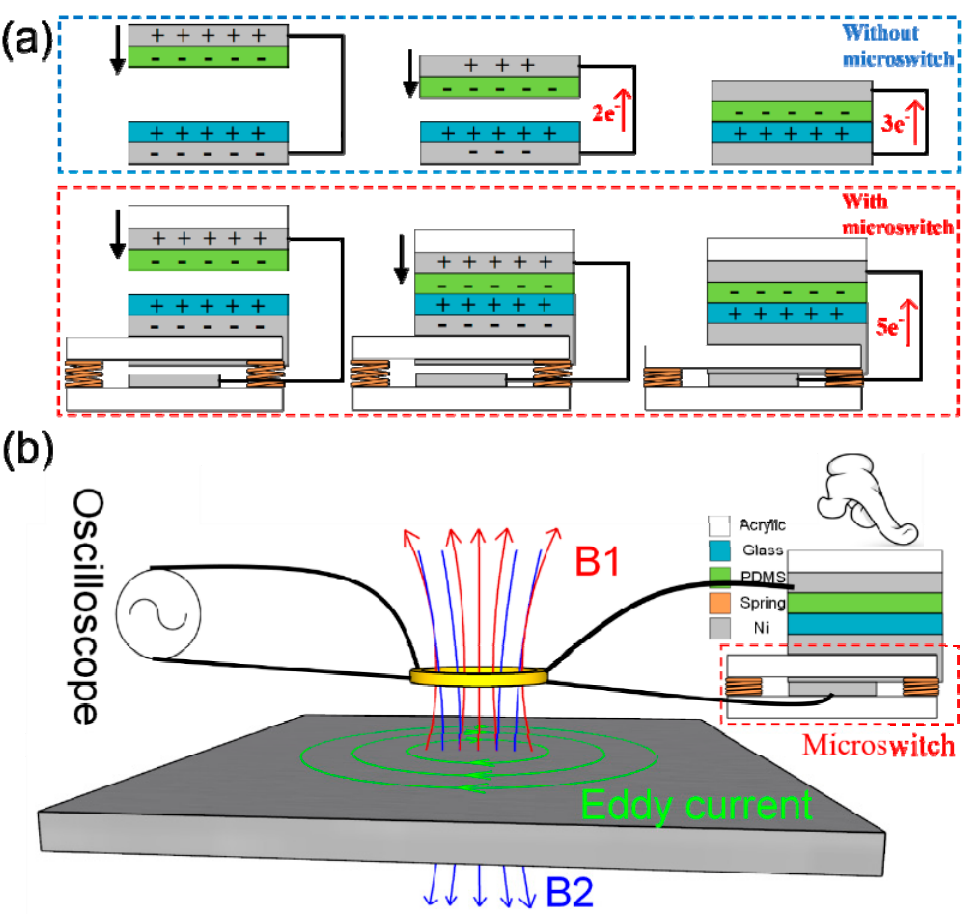
Figure 2. ( a ) Charge transfer process with and without the enhancement of microswitch and ( b ) schematic of the proposed TENG-based resonant sensor for non-destructive defect detection.